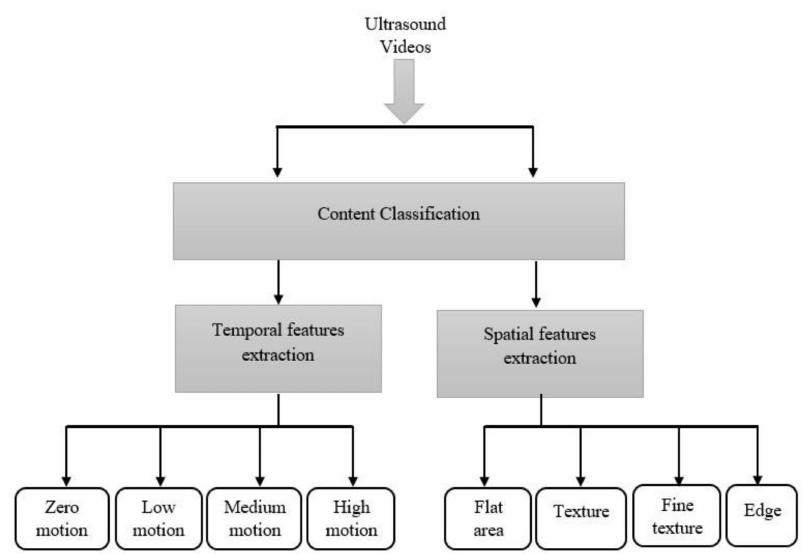
Figure 2. Content classification